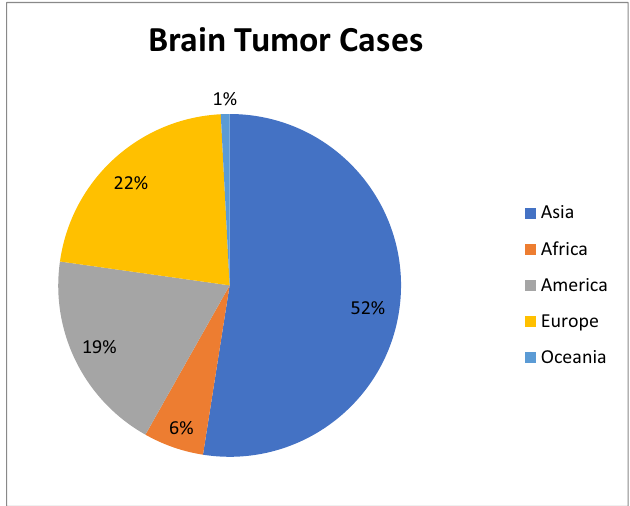
Figure 1: Continental - wise brain tumor cases in 2018.